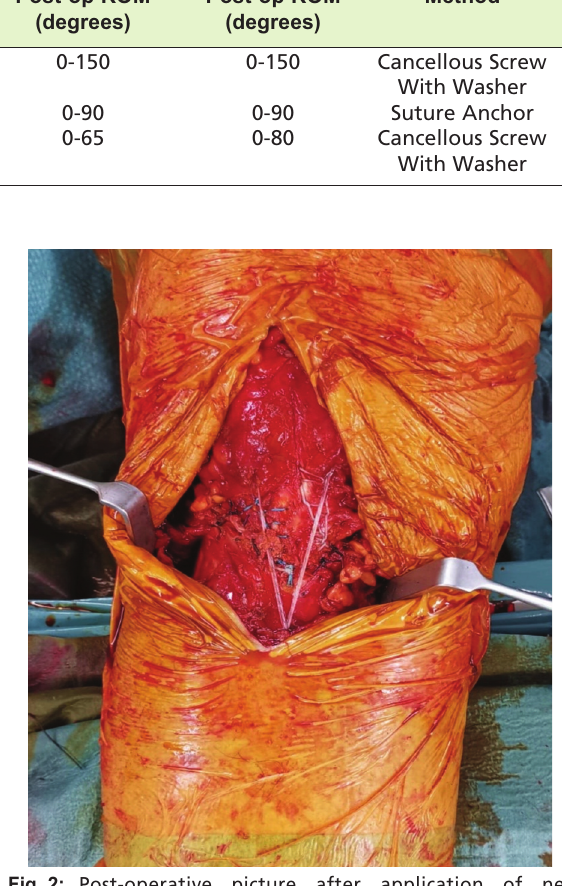
(a) Anterior (b) and lateral view of right knee. Fig. 1: